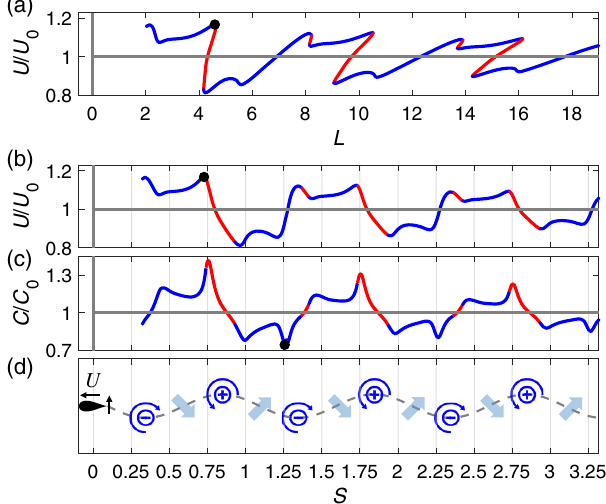
FIG. 3. Speed-up and cost of transport in an in-line formation. (a) Speed U of an in-line formation of swimmers separated by a distance L , as predicted by Eq. (3), compared to the speed U 0 of a single isolated swimmer. The fastest formation has U=U 0 ¼ 1 . 17 for L ¼ 4 . 6 , corresponding to S ¼ 0 . 73 (black dot). (b) Speed-up U=U 0 from (a) plotted in terms of the schooling number S . (c) Cost of transport C compared to that of a single swimmer C 0 . The most efficient state has C=C 0 ¼ 0 . 75 for L ¼ 6 . 3 , corresponding to S ¼ 1 . 26 (black dot). In (a) – (c), blue denotes stable or oscillatory states, red denotes unstable states, and the black dots indicate the fastest [(a),(b)] and most efficient [(c)] states. (d) Fluid flow (thick blue arrows) associated with the reversevonKármán street shed by a flapping swimmer. For a swimmer (not shown) located at a dimensionless distance S downstream, regions of downflow (up- flow) are typically associated with speed-up (slowdown) and higher (lower) cost of transport in (b) and (c). Dashed line indicates the upstream swimmer ’ s